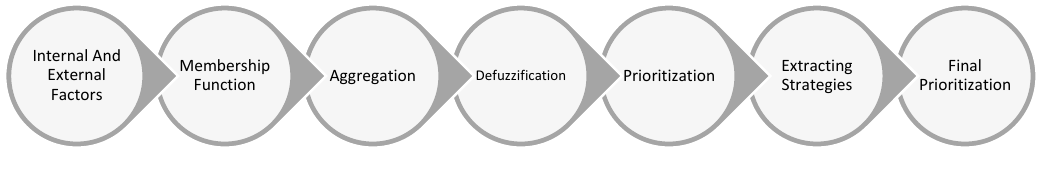
Figure 10. The stages of the proposed model.